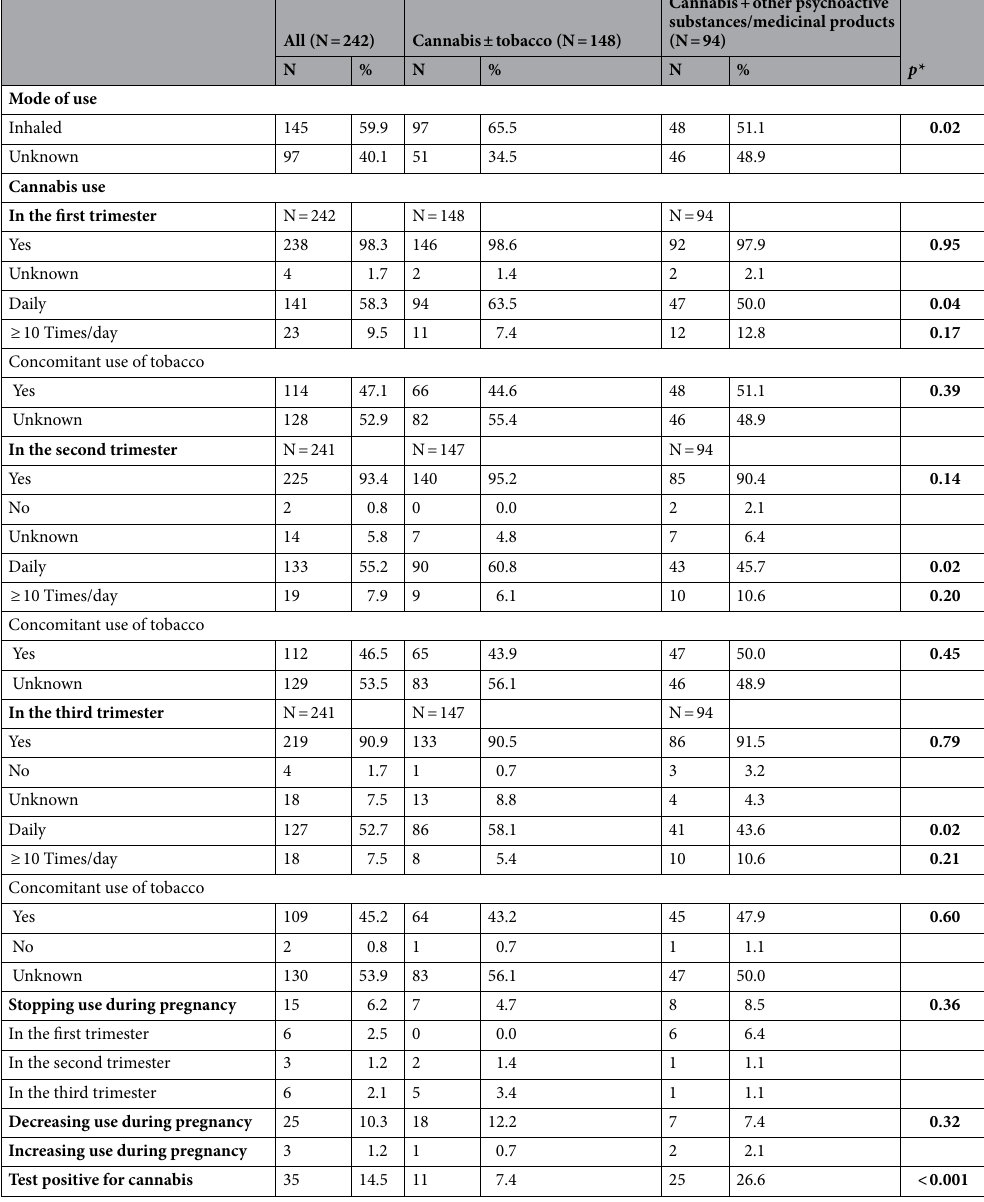
Table 2. Characteristics of cannabis use during pregnancy. *p value derived from Chi-square test for comparison of proportions. Significant values are in